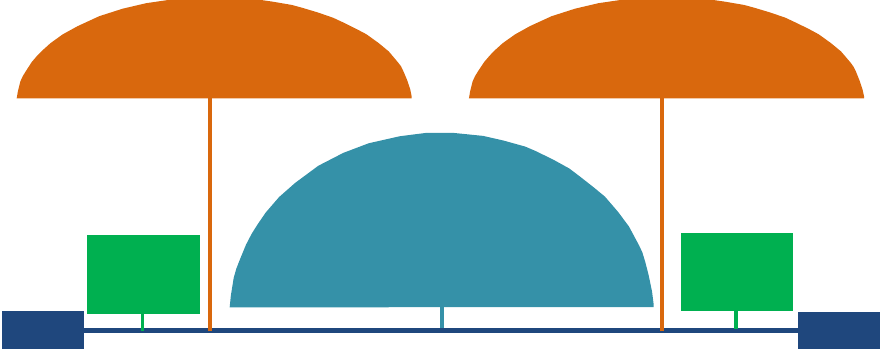
Figure 2. The layout of the initial low-pass filter.